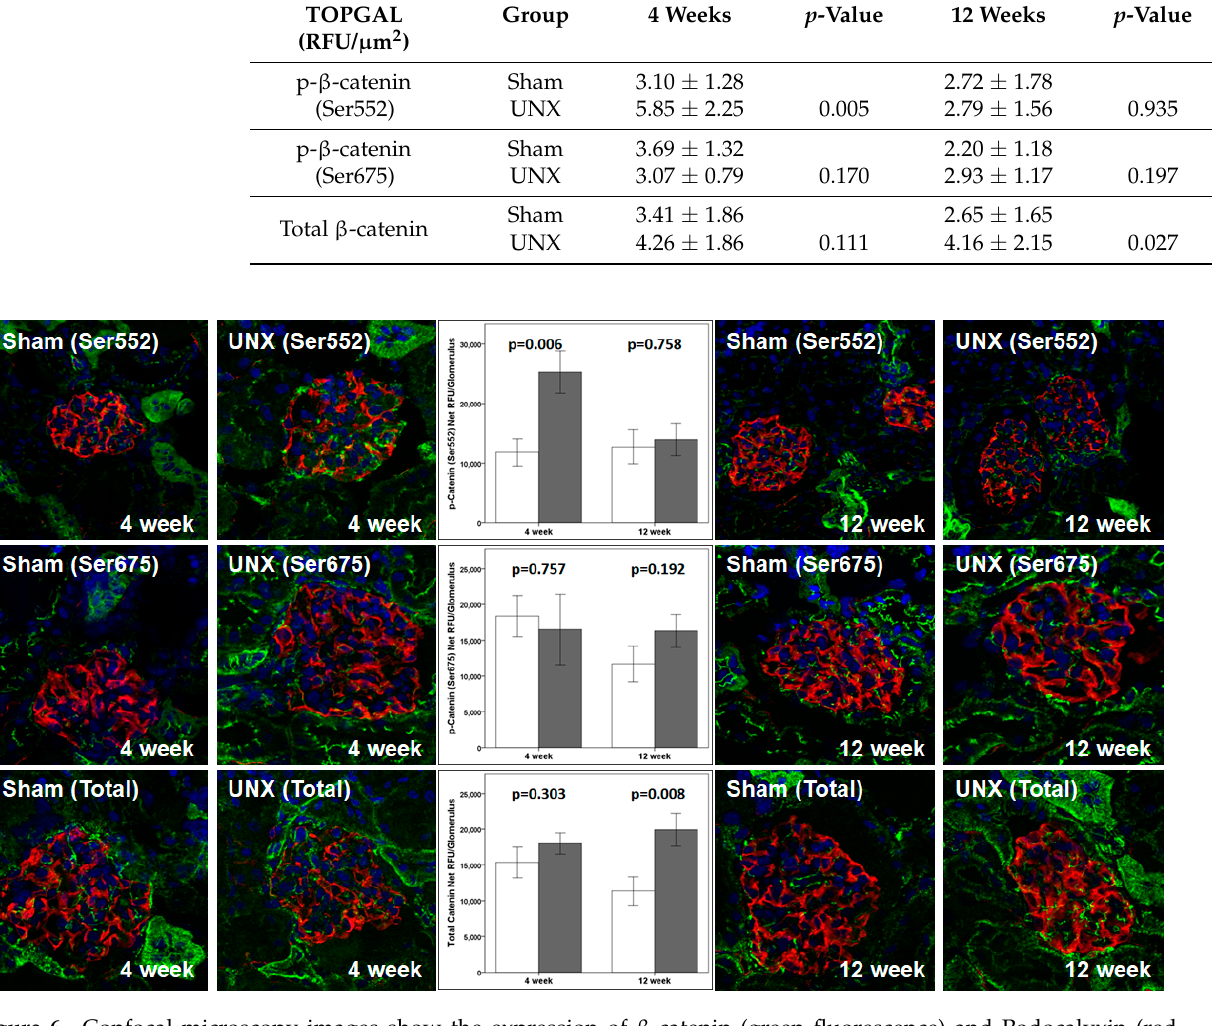
Figure 6. Confocal microscopy images show the expression of β -catenin (green fluorescence) and Podocalyxin (red fluorescence) in TOPGAL animals at 4 and 12 weeks following unilateral nephrectomy or sham treatment at 4 weeks of age. Unilateral nephrectomy is associated with glomerular hypertrophy. The bar graph shows the net relative fluorescence units/glomerulus. The values are shown as the mean relative fluorescence units [RFU] ± SD; the p -values were obtained using unpaired Students’ t -test.